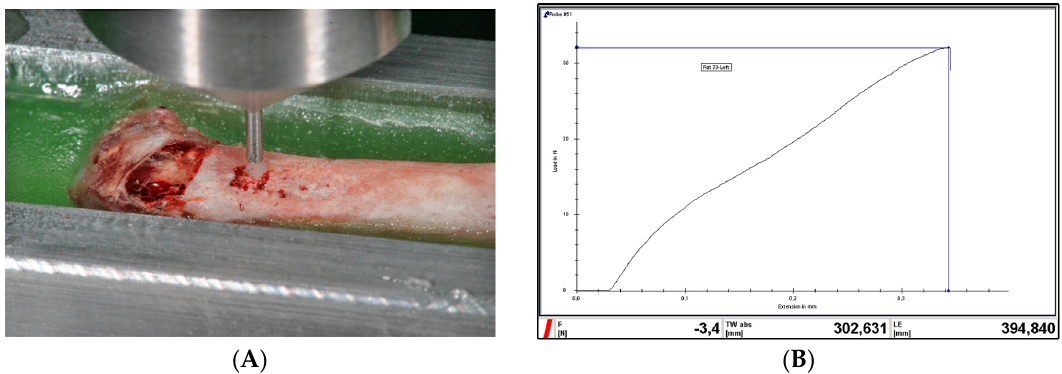
Figure 2. ( A ) Push in test: the implant is loaded in the universal testing machine; ( B ) a representative image showing the load-displacement curve during the push-in test. The highest load peak before a sudden drop in the curve denotes the push-in